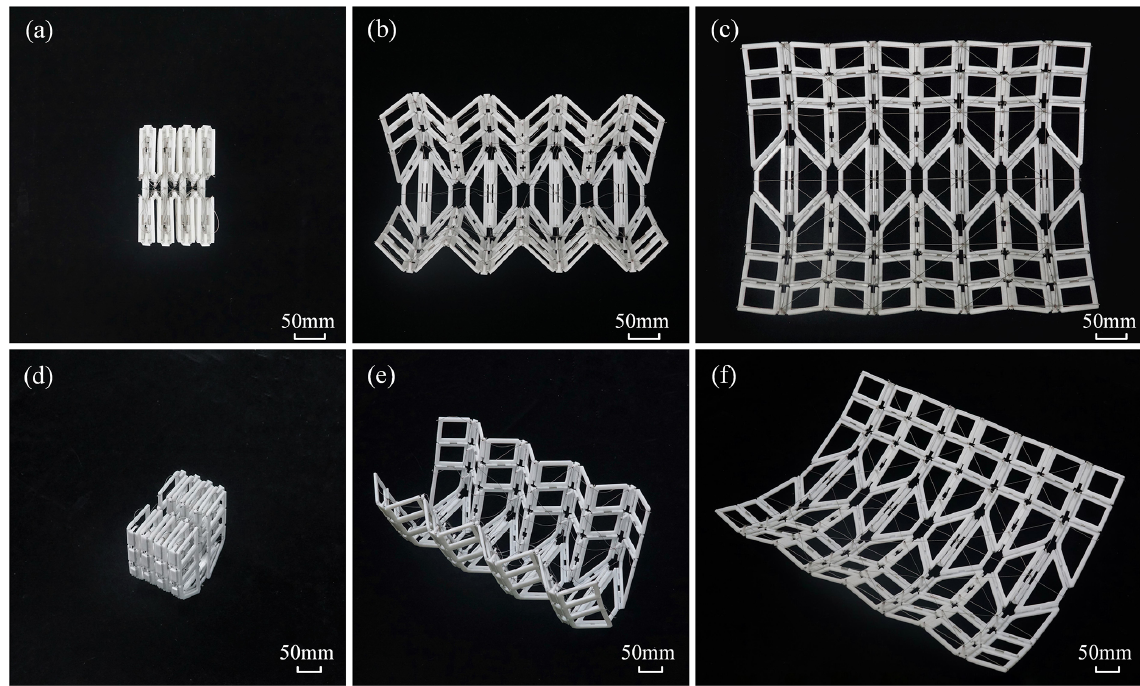
Figure 12. Scaled prototype of the parabolic cylindrical deployable